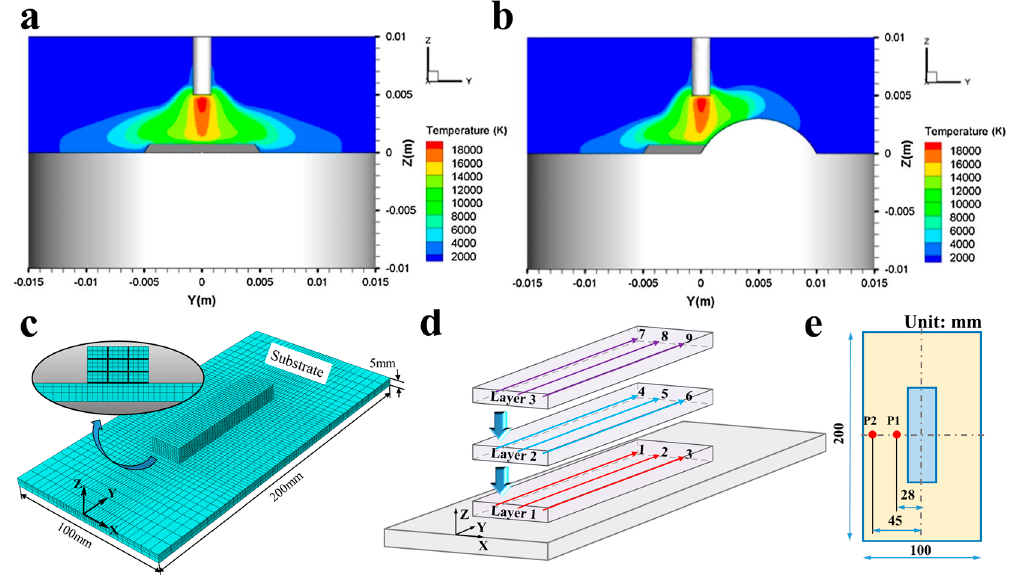
Figure 4. Simulated results of arc temperature of ( a ) single-bead deposition; ( b ) overlapping deposition [13]; ( c ) Three dimensional thermal model and finite element mesh; ( d ) Deposition